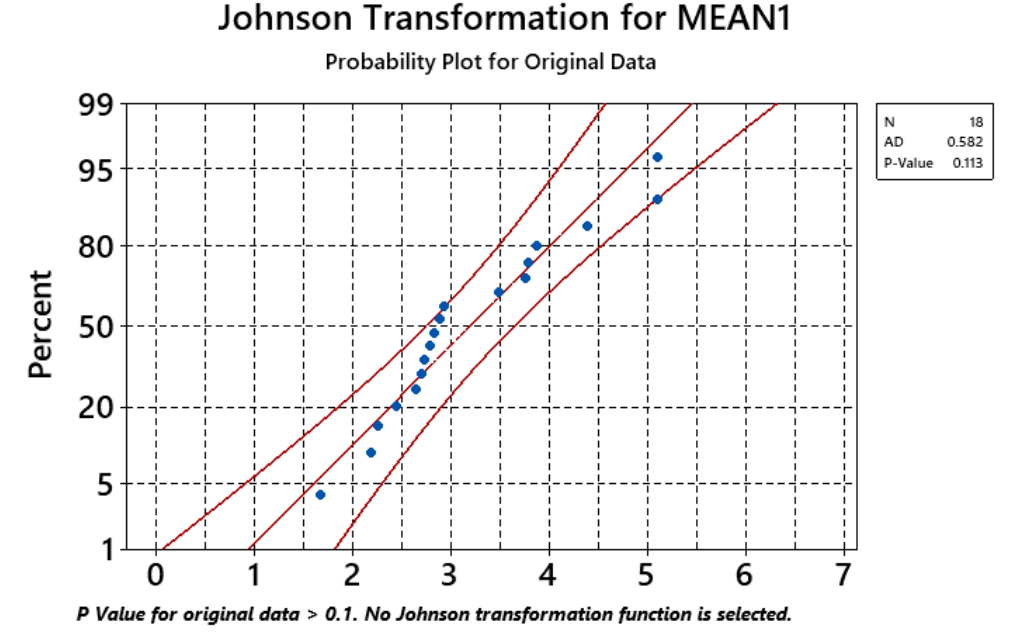
( b ) Johnson transformation for MEAN1.